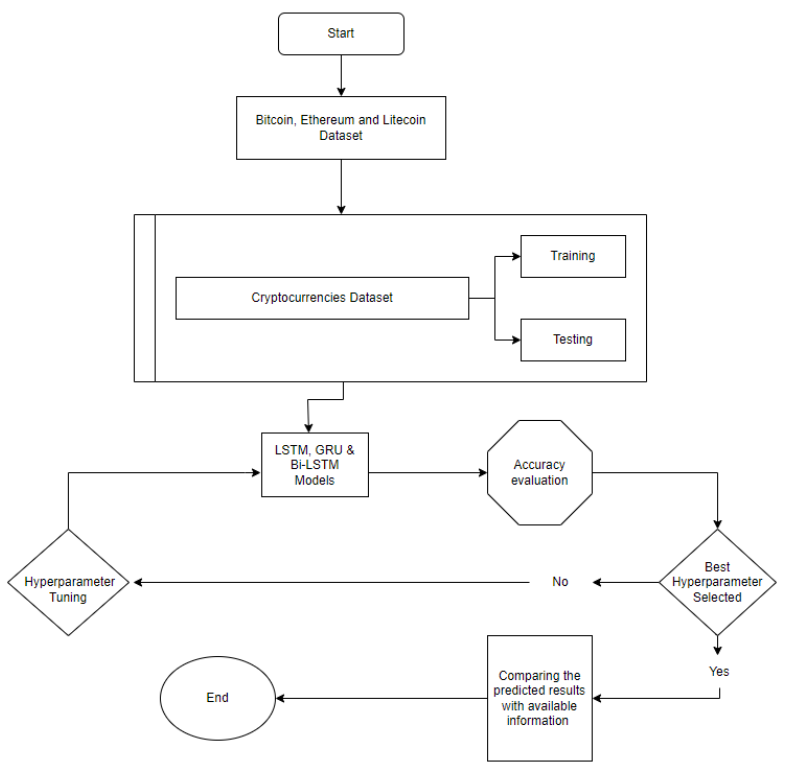
Figure 1. Methodology of processing data and model